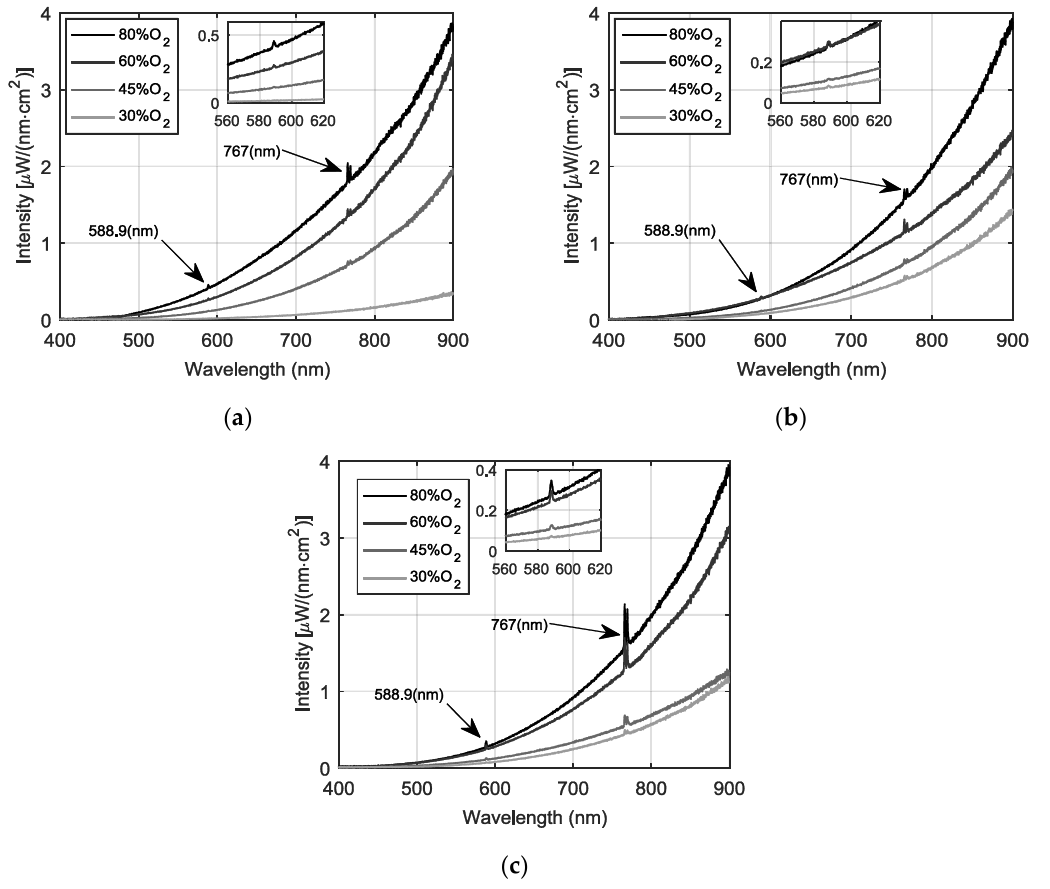
Figure 2 . Emitted spectra during the flash smelting process, for three different copper concentrates with a: ( a ) S/Cu ratio of 1.07; ( b ) S/Cu ratio of 1.27 and ( c ) S/Cu of 1.85.